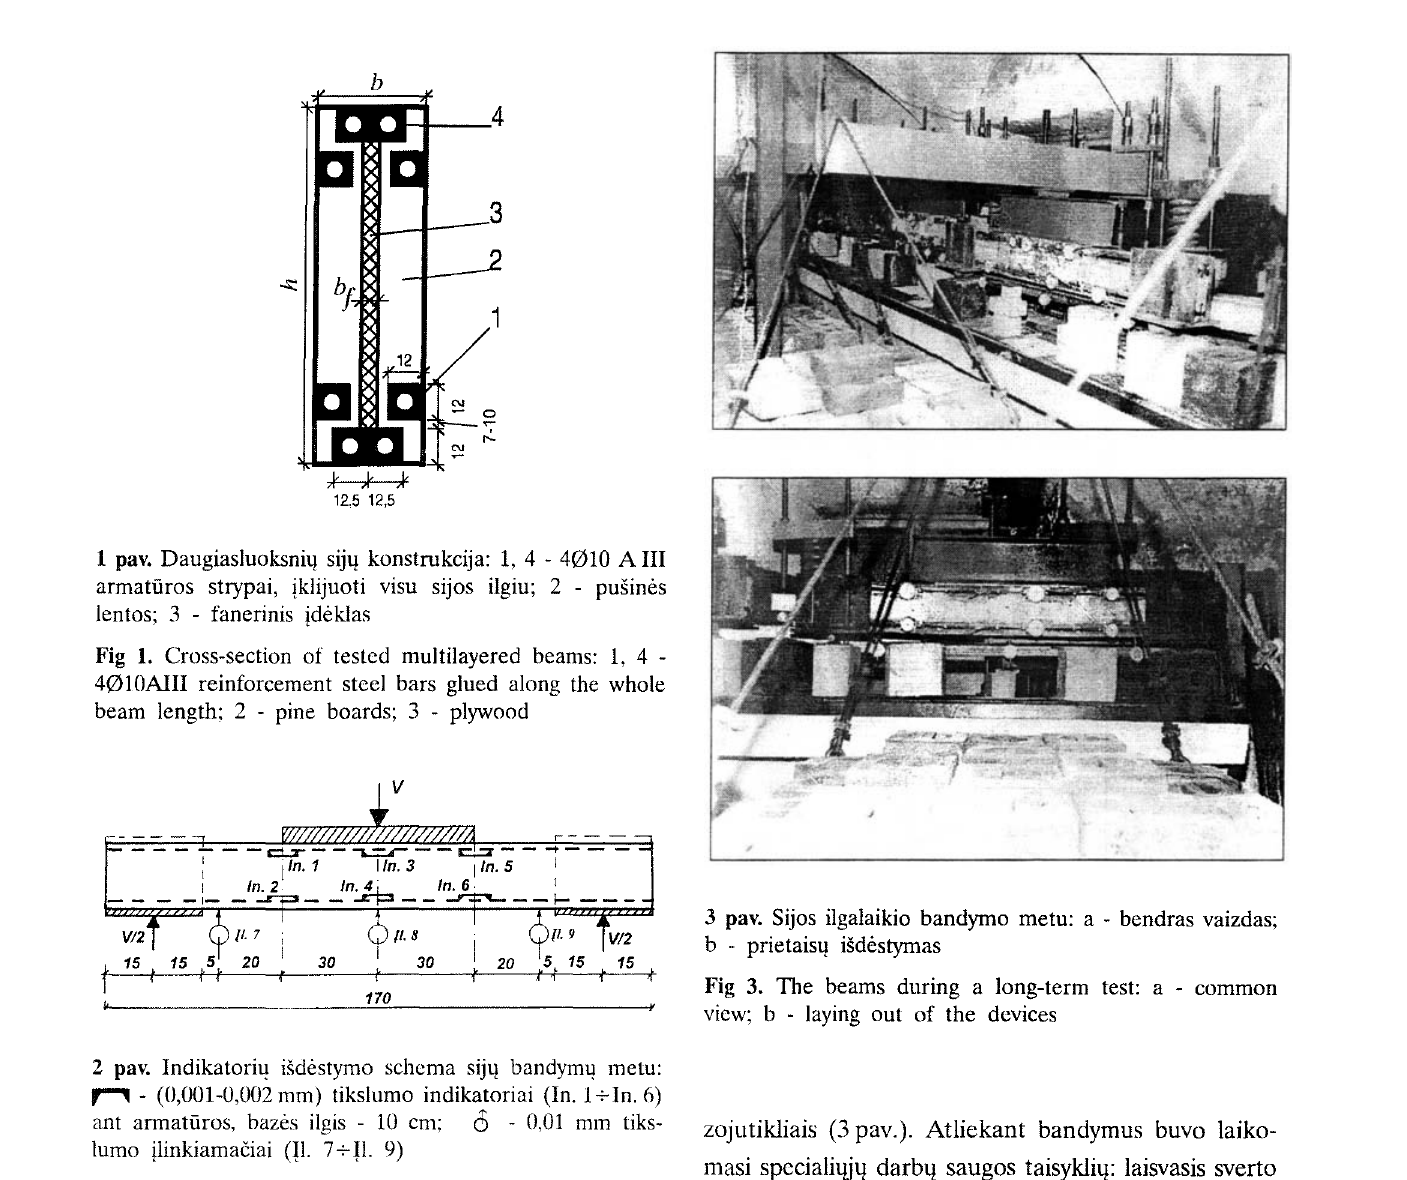
Fig 1. Cross-section of tested multilayered beams: 1, 4 - 4010Alll reinforcement steel bars glued along the whole beam length; 2 - pine boards; 3 - plywood v